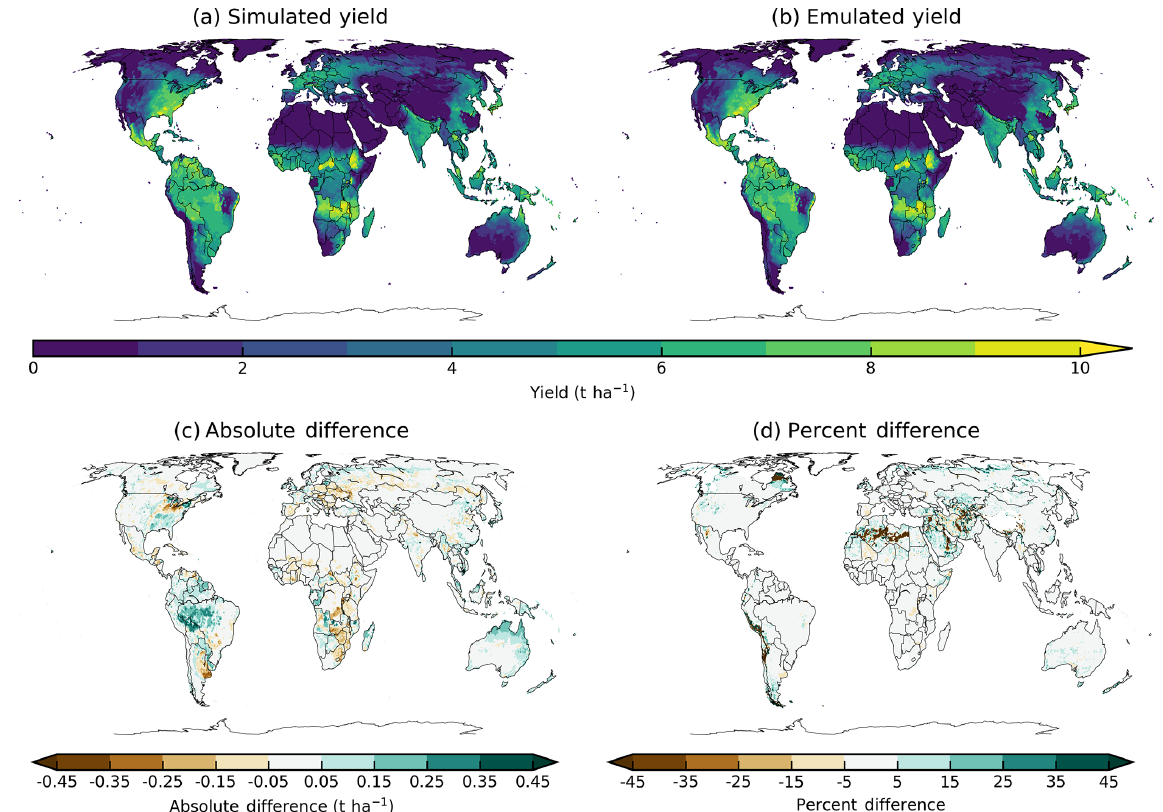
Figure 4. Illustration of spatial pattern in baseline yield successfully captured by the emulator: simulated (a) and emulated (b) yield under historical (1981–2010) conditions for rainfed maize from the LPJmL model. Absolute yield differences (c) are less than 0.5tha − 1 in almost all (99.8%) grid cells across the globe. Percent difference (from simulated baseline, d ) is below 5% in most (75%) grid cells currently cultivated in the real world. Approximately 7% of all grid cells, but only 3% of currently cultivated grid cells, have emulated yields that differ from the baseline simulation by more than 20%. Notable exceptions include areas with very low simulated baseline yield, including, for example, the Sahara, the Andes, and northern Quebec. Percent error weighted by cultivation area globally is essentially zero (see also Table 3). Performance varies by crop and model. See Supplement figures in Sect. S8 for more